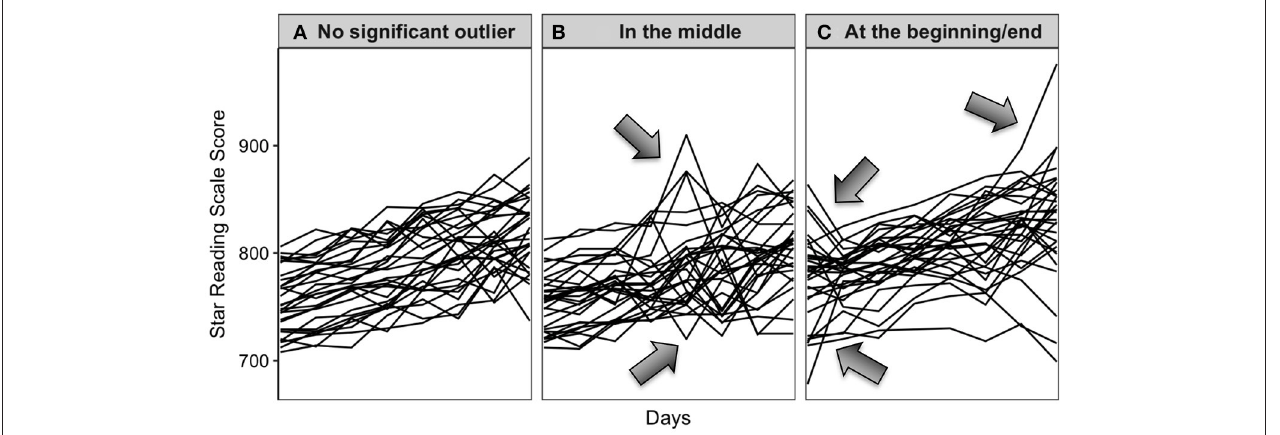
FIGURE 1 | Different patterns of outliers ( A : no outlier, B : outlier in the middle, or C : outlier at the beginning/end) in the progress monitoring data from Star